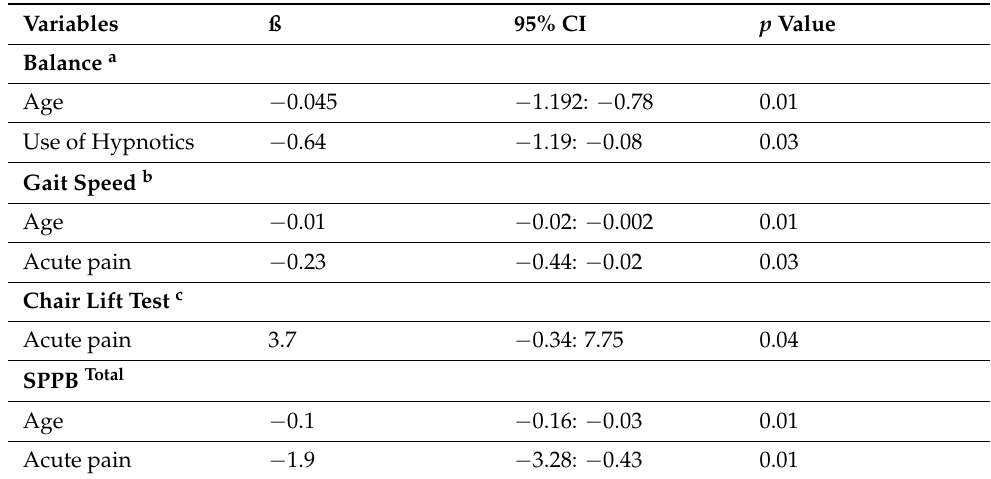
Table 4. Multivariate Analysis of Functional Performance, Natal, RN, 2016. ( n = 133). Variables